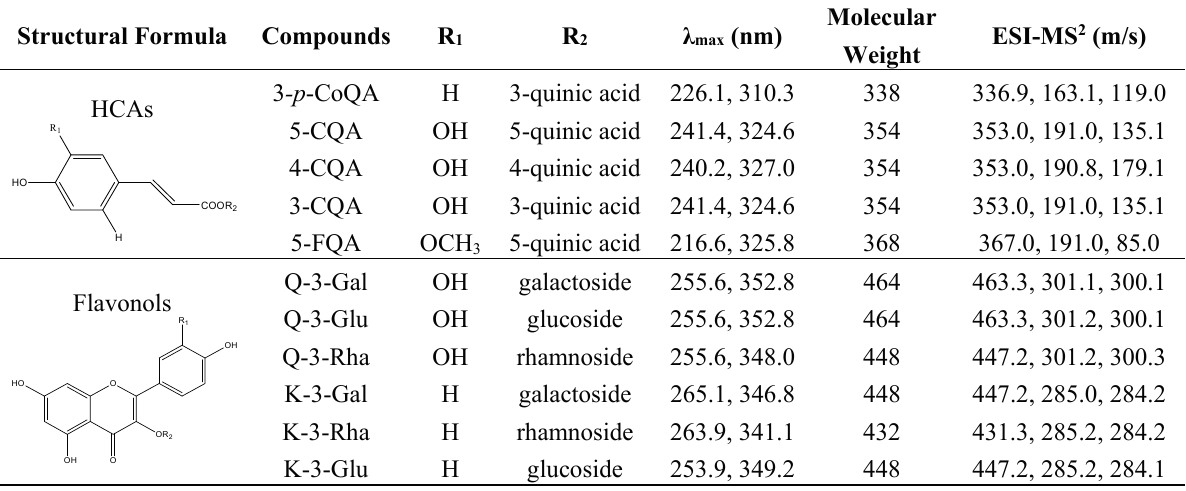
Table 2. Structural and chromatographic characteristics of investigated phenolic compounds. Structural